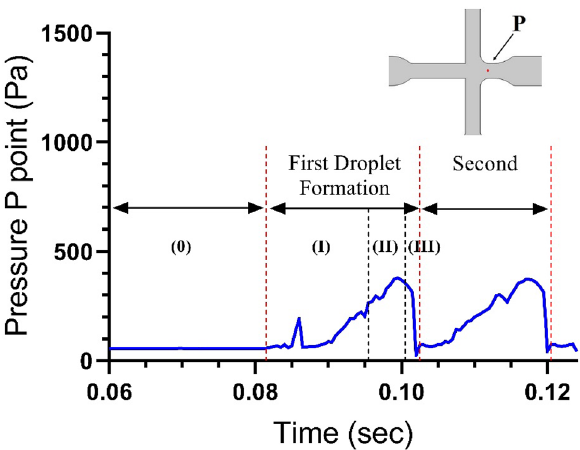
Figure 4. The procedure of the pressure slope at the P point for the duration of droplet configuration. The P point decides the point situated at the main duct entry. It reverberates the development of the droplet formation process. Three steps formation of droplet: (I) Lag, (II) Filling, and (III) Necking. The CS + DOX velocity is stable at 3.3 mm/s, and the velocity of vegetable oil is equal to 11.1